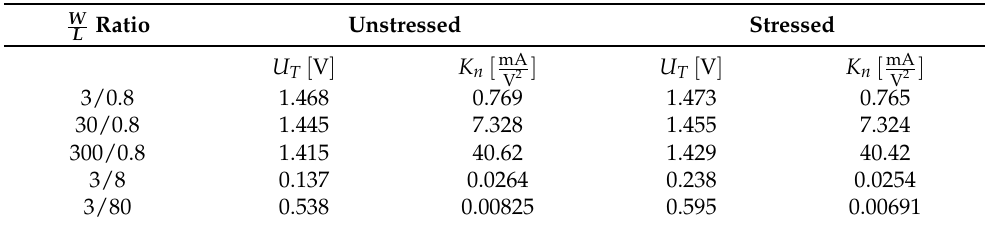
Table 1. K n and threshold voltages of transistors in the pristine state (unstressed) and subjected to mechanical stress (compressive) strain (cid:15) = 0.2%. W Ratio Unstressed Stressed L ] U [ V ] K n [ mA ] U T [ V ] K n [ mA T V 2 V 2 3/0.8 1.468 0.769 1.473 0.765 30/0.8 1.445